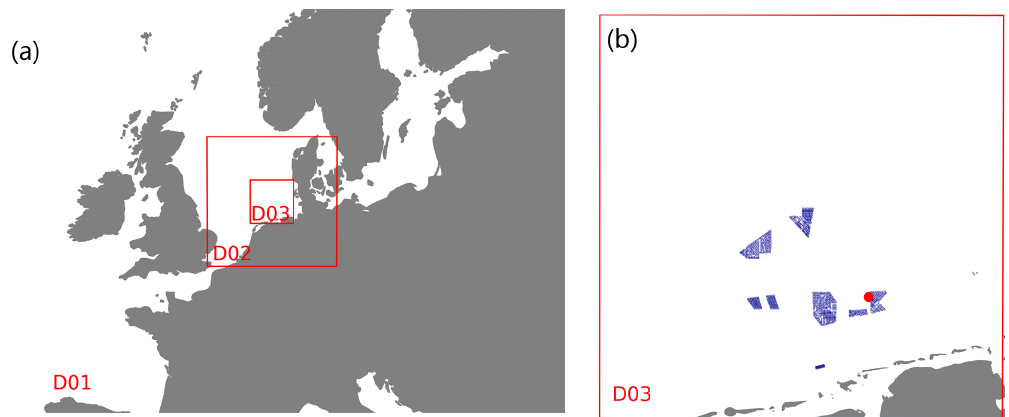
Figure 7. (a) Locations of the three WRF model domains (D01, D02, D03) with a grid sizes of 18, 6 and 2km, respectively. The innermost domain (D03) of (a) is shown in detail in (b) with the locations of the wind turbines accounted for in the simulations and the location of the lidar measurements marked in red. Note that wind farms with a distance of more than 100km from the site were